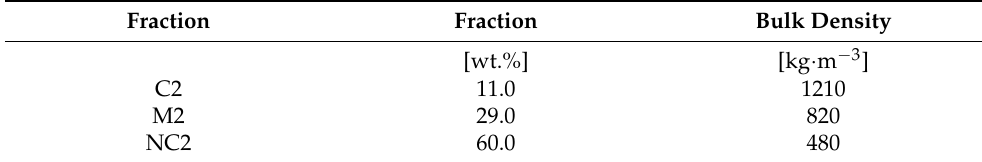
Table 6. Weight fractions and bulk density of the ESS fractions.